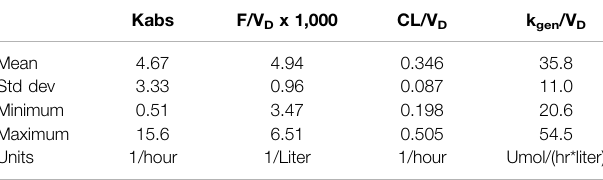
TABLE 4 | Parameters from individual fi t.